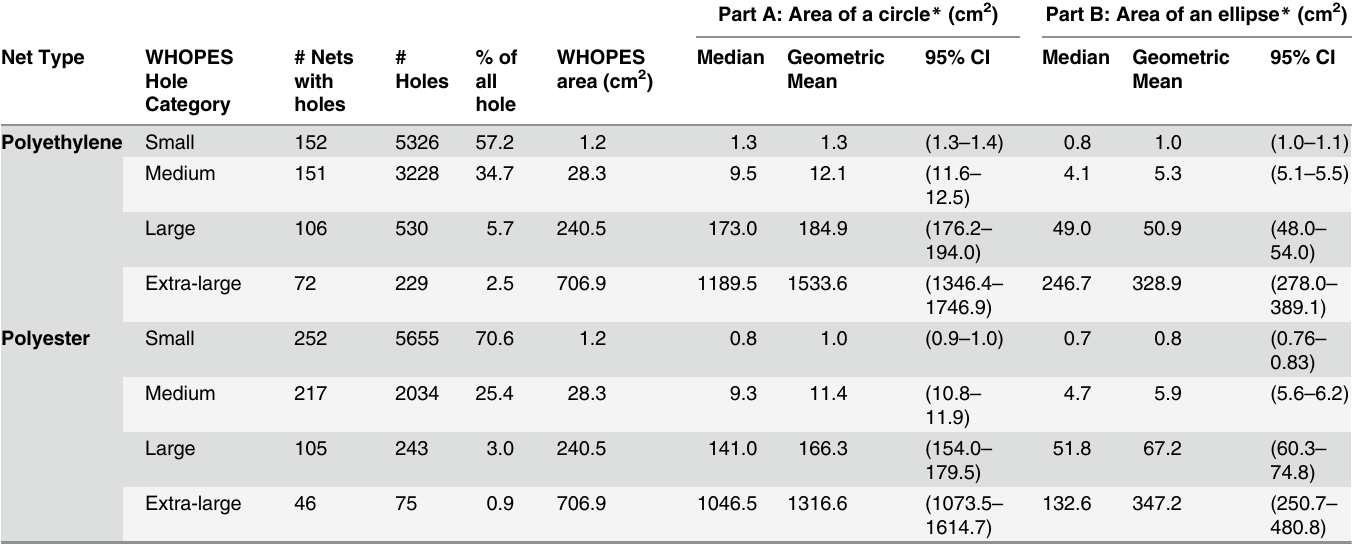
Table 2. Calculated hole areas (cm 2 ) for each WHOPES size category, by net type.